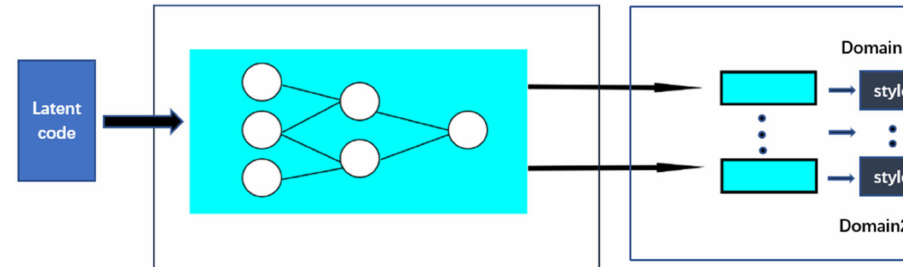
Figure 1. Mapping network.